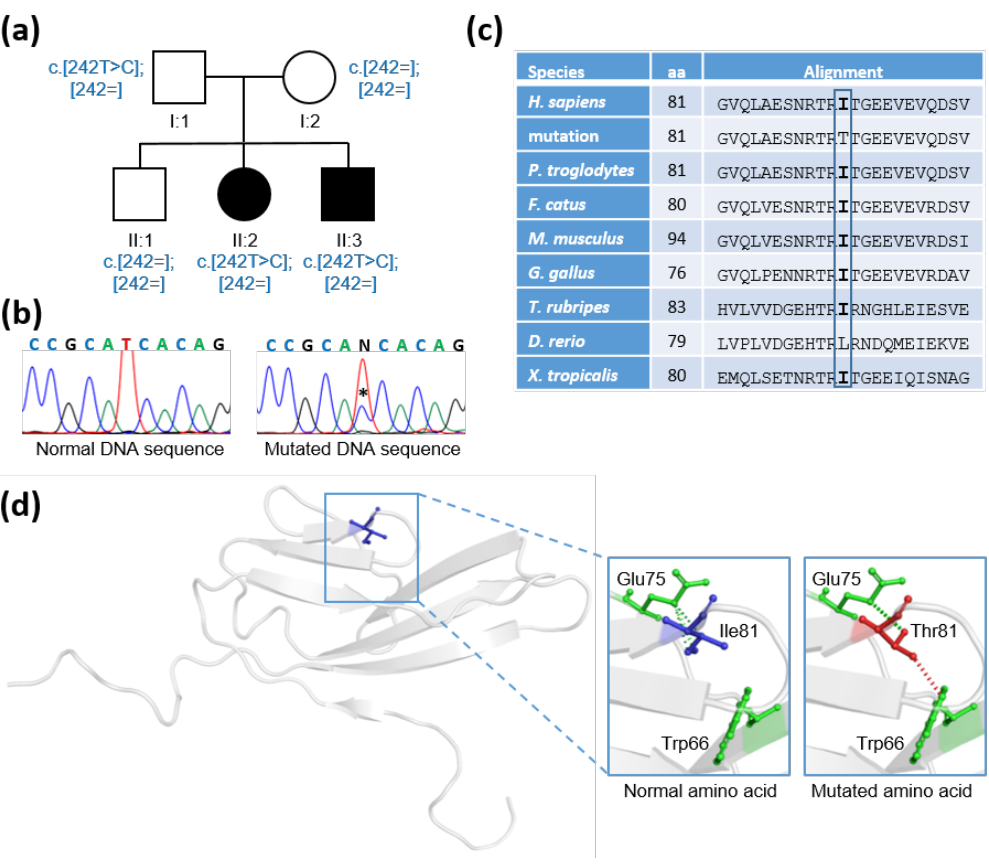
Figure 1. ( a ) Pedigree of the patients with congenital hypogonadotropic hypogonadism (CHH). Indi- viduals are represented as males (squares), females (circles), affected (filled symbol), and